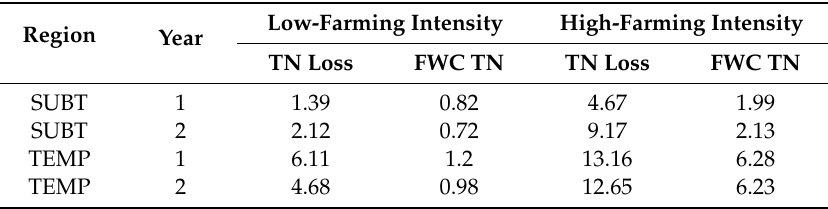
Figure 2. Variability in total nitrogen (TN) concentrations for each of the four fortnightly grabs sampled benchmark streams. Data correspond to a 2-year period. ANOVA results: F TEMP vs. SUBT (1,190) = 23.73, Farming intensity conditions nested in climate / hydrology (2,190) = 70.44, F Interaction (1,190) = 378.9. P < 0.001 for all cases. A, B, and C describe statistically similar groups according to Bonferroni post hoc tests. The upper and lower boundaries of the box mark the 25th and 75th percentile, whiskers above and below the box indicate the 90th and 10th percentiles and the line within the box marks the median. Black dots display outliers. Abbreviations: TEMP: temperate streams; SUBT: subtropical streams; low and high: low and high-farming intensity in the catchments. Table3. Totalnitrogenlosses byhectare(kgN · ha − 1 · year − 1 )and flow-weightedconcentrations(FWC; mg N · L − 1 ) estimated annually using high frequency automatized pooled sampling of the four benchmark streams (water samples taken every 4 h and accumulated fortnightly). Abbreviations: TEMP: temperate streams; SUBT: subtropical streams; low and high: low and high-farming intensity in the